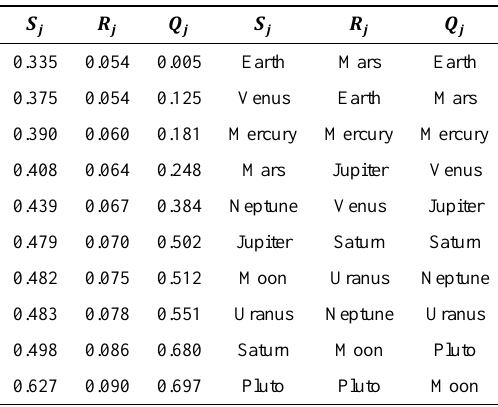
Table 6. Ranking by